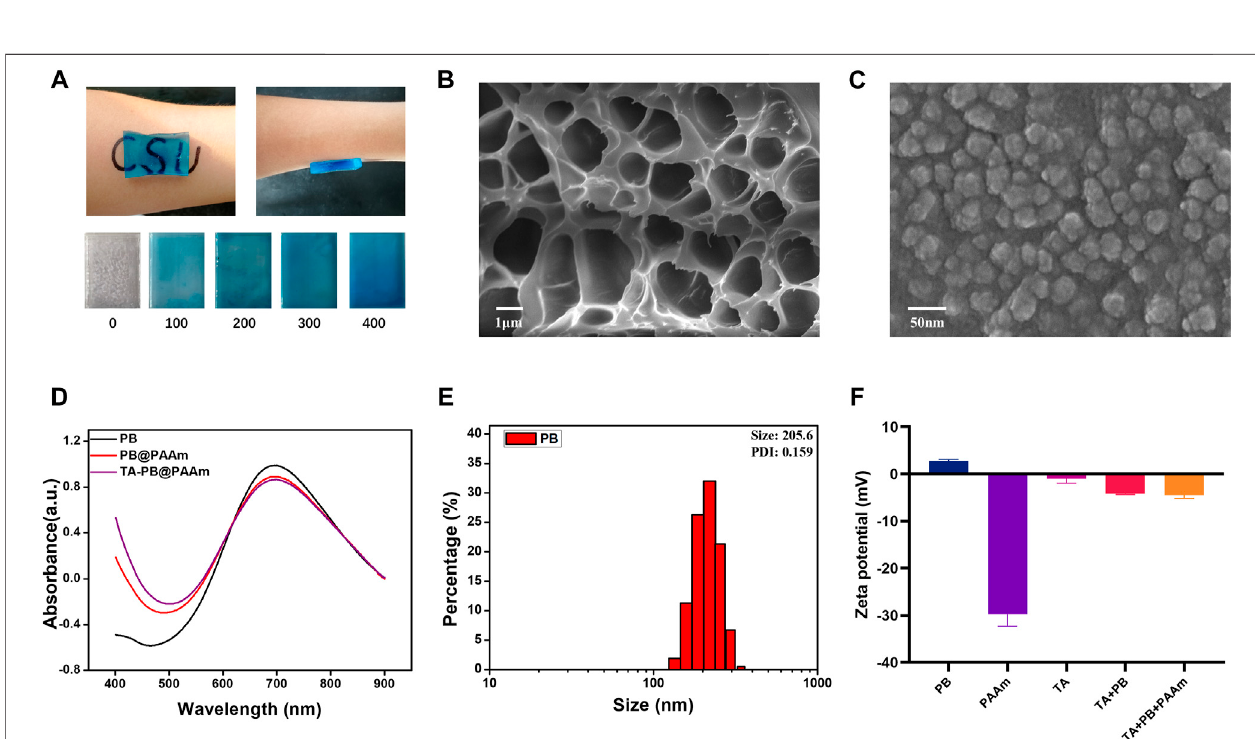
FIGURE 2 | Physical and chemical characterization of hydrogel composites. (A) Appearance of the materials, which are prepared with different concentrations of Prussian blue and the adsorption properties (unit (cid:1) ug/ml). (B) Porous structure of formed composite photothermal hydrogels. (C) SEM microscopic morphology of Prussian blue nanoparticles. (D) UV absorption spectra of PB, PB@PAAm and TA-PB@PAAm. (E) Particle size distribution of Prussian blue nanoparticles. (F) Zeta potential of PB shows positive charge.